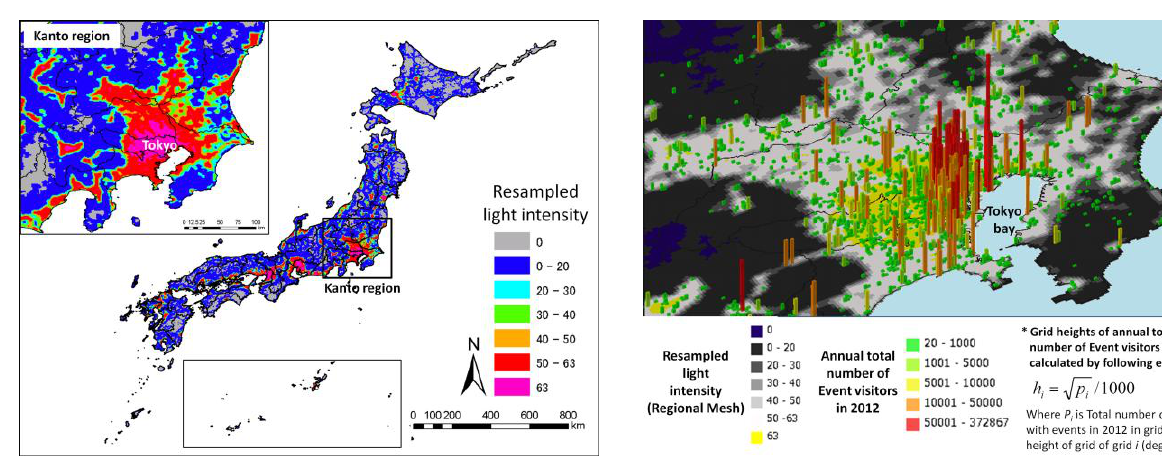
Figure 6. Resampled light intensity of the DMSP/OLS image into the Regional Mesh all over Japan in 2012